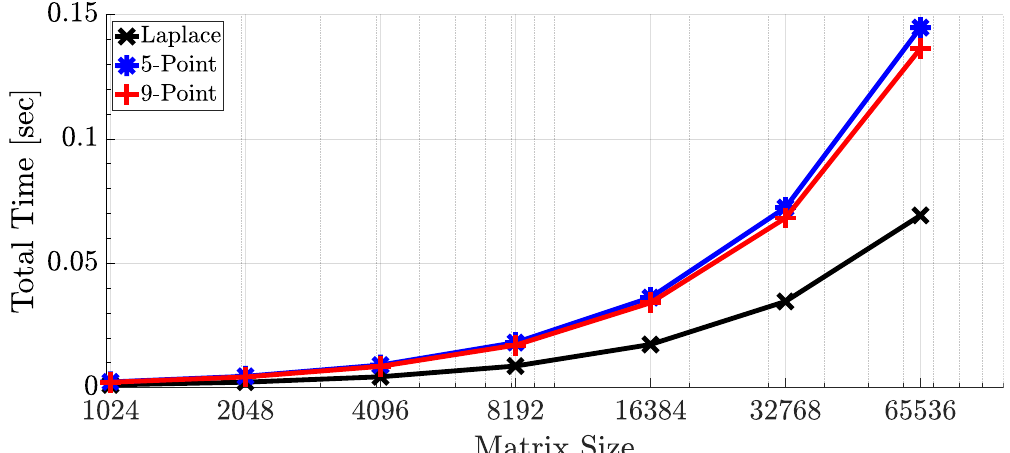
Figure 6. Single iteration run times of three stencil codes with variable array sizes of nxm where n is set as 4096 and m is between 1 K and 64 K.